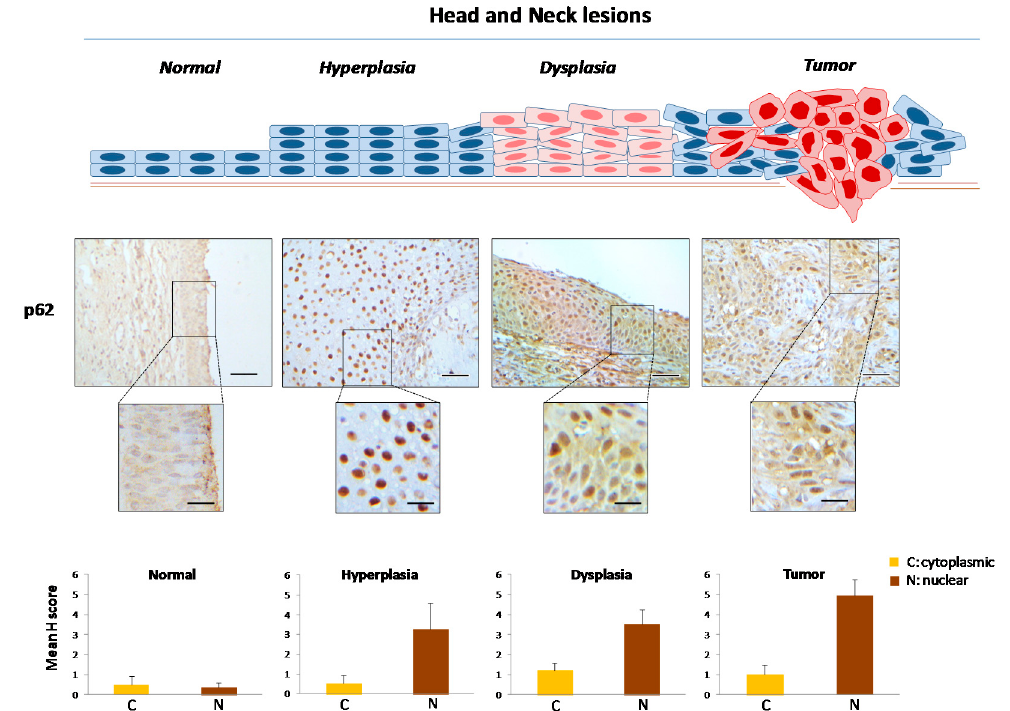
Figure 6. Immunohistochemical expression patterns of p62 in head and neck lesions. Representative images of cytoplasmic and nuclear immunohistochemical localization of p62 in normal laryngeal epithelium, hyperplastic and dysplastic lesions, as well as in tumor areas from the same patient. Bars in the histograms denote the cytoplasmic and nuclear mHscores of p62 in each stage (± SE: standard error). Scale bars: 100 μ m; scale bars of insets: 50 μ m.